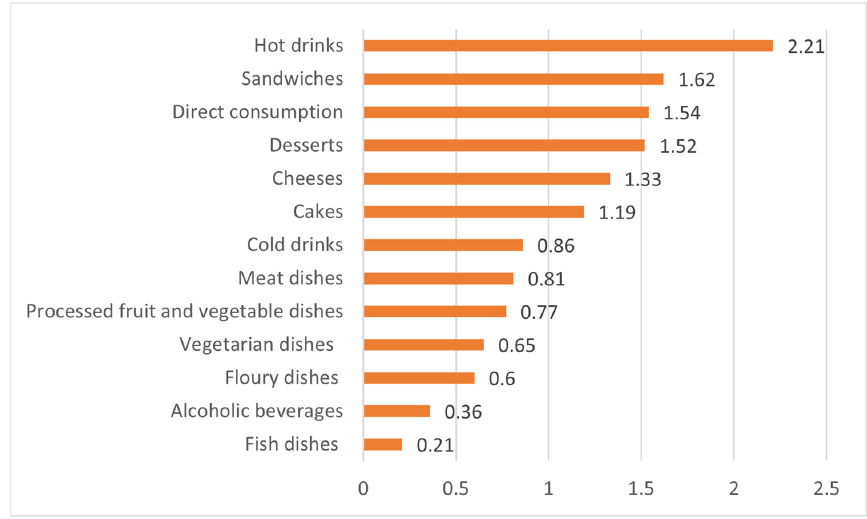
Figure 2. Patterns of honey consumption ( n = 434, average on a scale: 0—not at all, 1—several times a year or less, 2—once a month on average, 3—5–8 times a month, 4—several times a week, 5—daily or almost daily).